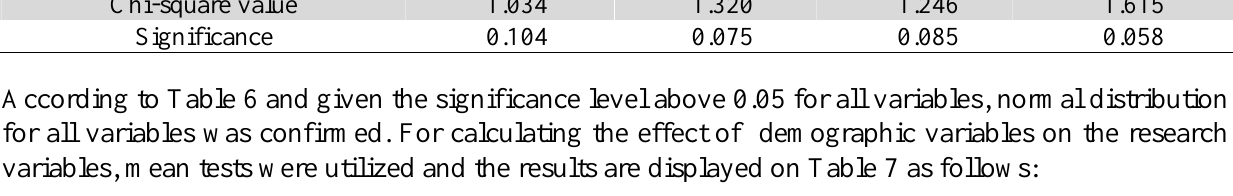
Normality tests of research variables distribution based on Koran test Latent variables of the